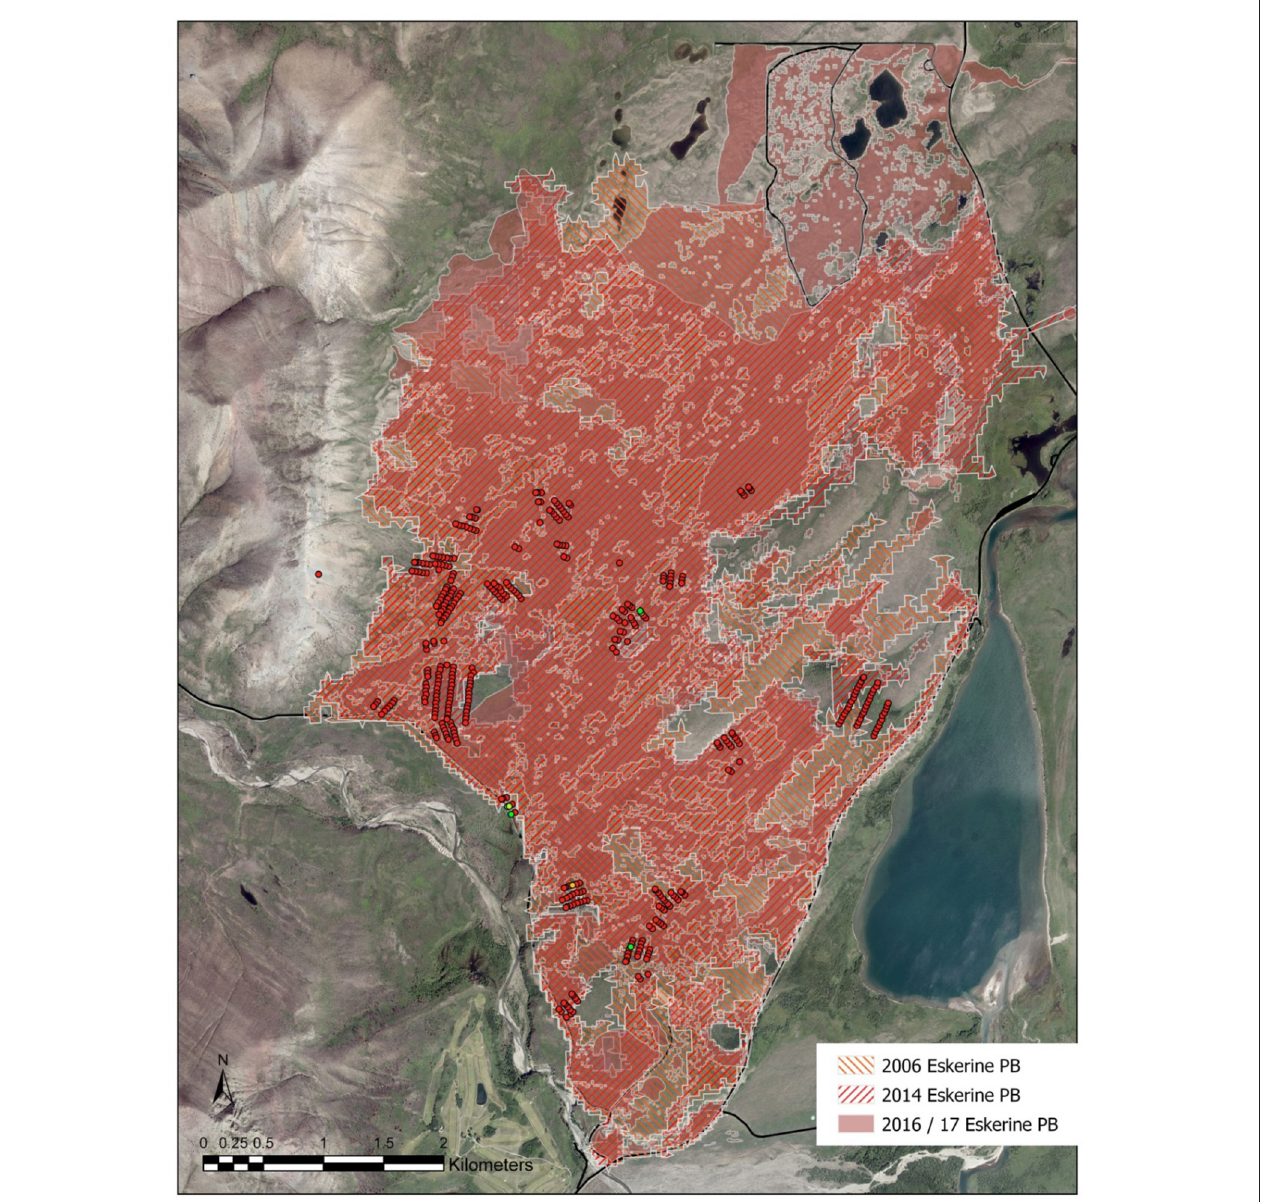
FIGURE 1 | Prescribed fires 2006–2017, Waterton Lakes National Park. Shows the extents of three prescribed burns (PBs) on the Eskerine Complex grassland area of Waterton Lakes National Park, map by Adam Collingwood. Does not include the Kenow wildfire, which covered 100% of the area and is presented in Figure 2 .